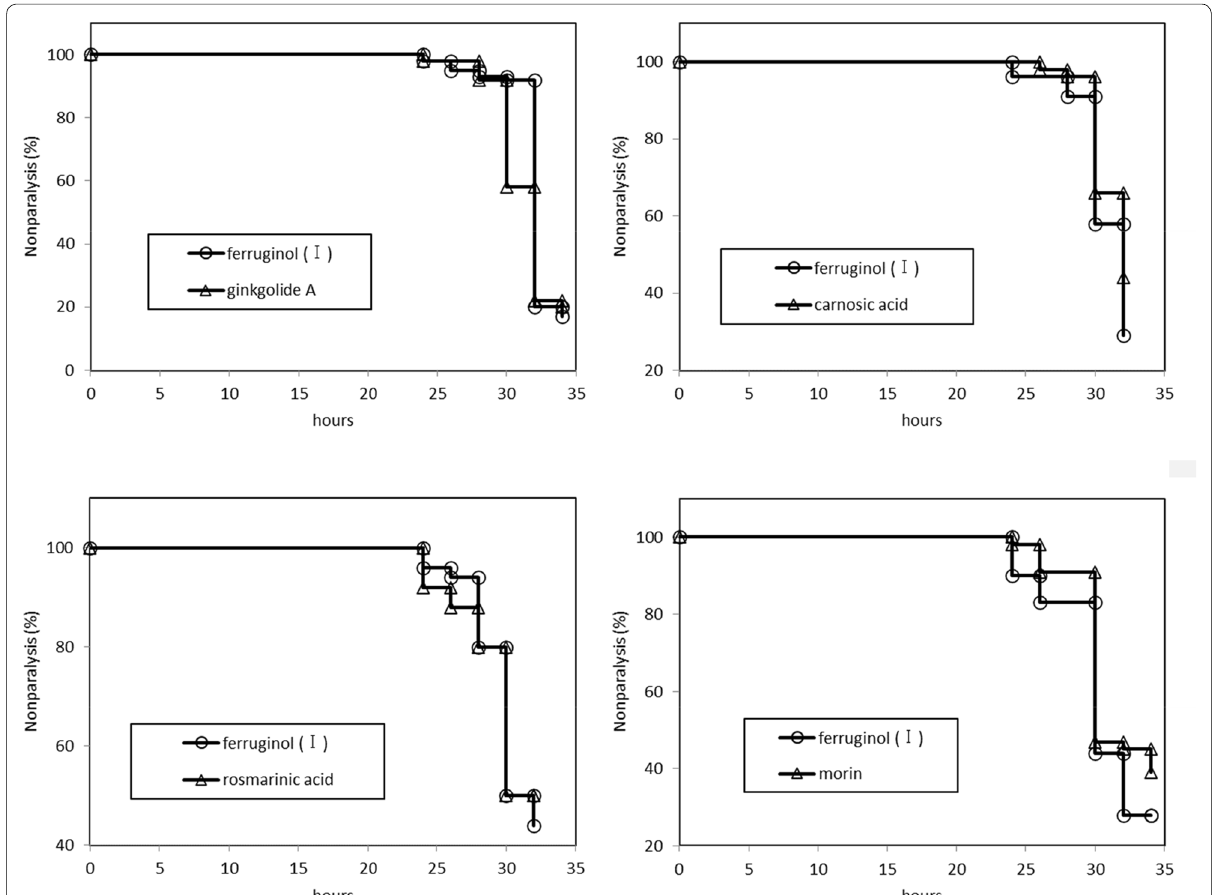
Fig. 4 Time course of paralysis assays in C.elegans CL4176 fed with ferruginol and reference compounds (anti-Alzheimer’s disease active compounds)